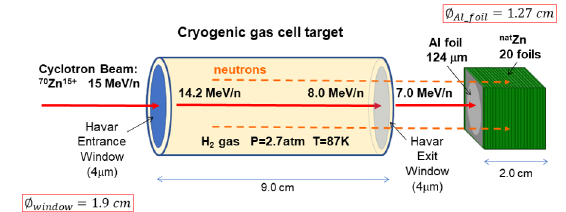
Fig. 1. (Color online) Schematic diagram of the irradiation setup. The energies of the beam are listed as it passes through the entrance window, the gas and the exit window (thick arrows). The dashed arrows represent the neutrons produced via the interactions of the 70 Zn beam with the hydrogen gas and the Al catcher [1].